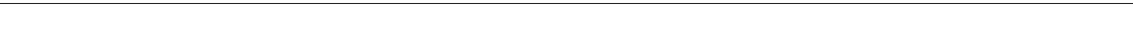
Fig. 8 Inhibition of Plk1 by RNAi or BI6727 increases the incidence of intestinal polyps in mice. a Scheme of the experimental procedure for the generation of transgenic mice. b Total cellular protein was prepared from the intestinal tissues of adult Plk1-iKD (±Dox) and separated by SDS – PAGE for anti-Plk1, -itetR, and - β -Actin immunoblotting analyses. c Hematoxylin/eosin-stained sections of normal and tumor tissues from Plk1 iKD , Apc Min/ + Plk1 iKD and Apc Min/ + mice (±Dox) (×100). Sections were subjected to immunohistochemical evaluation after staining with IgGs to Ki-67 (×100). Black arrows highlight low grade (C,E) and high-grade (D,F) adenomas. ( d ) Mice of different genotypes and treatment schedules were sacri fi ced. Intestines from each mouse were examined using the Swiss role technique under a dissection microscope for tumor polyps. Average number of adenomas in colon and the small intestine from Plk1 iKD , Apc Min/ + Plk1 iKD with or without Dox-treatment, Apc Min/ + with or without BI6727-treatment are shown. No visible tumor masses were detected in WT and Plk1 iKD mice. e Sections of intestines from each mouse were examined under the microscope for the determination of the histological grade. Quanti fi cation of low and high grade adenomas in the small and large intestine from Apc Min/ + Plk1 iKD with or without Dox-treatment, Apc Min/ + with or without BI6727-treatment are shown. f Since the expression of the Ki-67 protein is strictly associated with cell proliferation, we used the staining of Ki- 67 in intestinal tissues to dermine the proliferative activity in corresponding sections. The staining was quanti fi ed based on different cutoff levels (<10%, ≤ 50% and >50%). (means ± s.d., n = 3, for each treatment). ** P < 0.01, *** P < 0.001, Student ’ s t -test, unpaired and